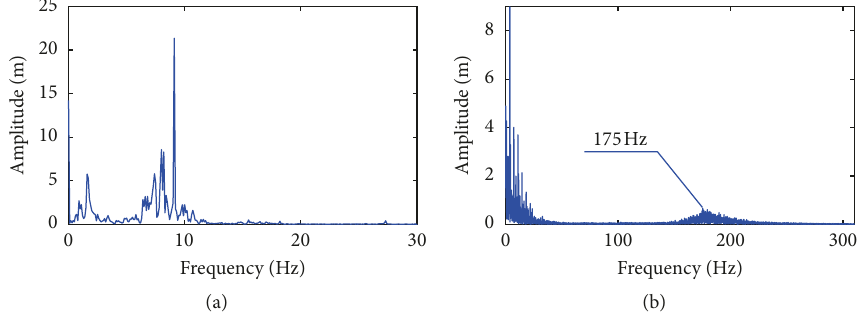
Figure 7: Frequency distribution of x